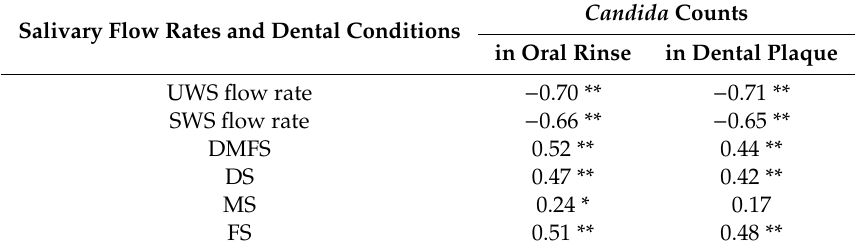
Table 4. Correlations (r s values) between Candida counts and salivary flow and dental conditions. Salivary Flow Rates and Dental